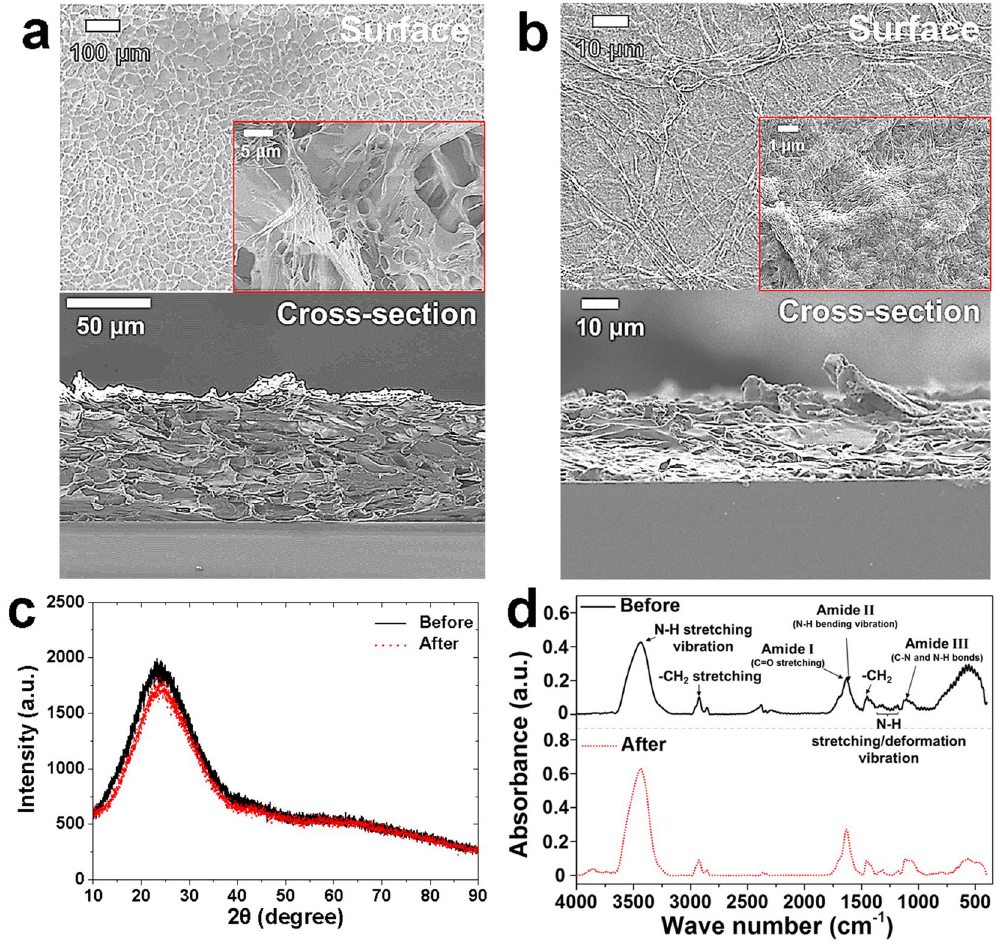
Figure 1. Structure and properties of hydrogel coatings SEM images of the surface morphology of the hydrogel coatings after freeze drying ( a ) before and ( b ) after hydration. ( c ) XRD data and ( d ) FTIR spectra for hydrogel coating before (black solid line) and after (red dash line)